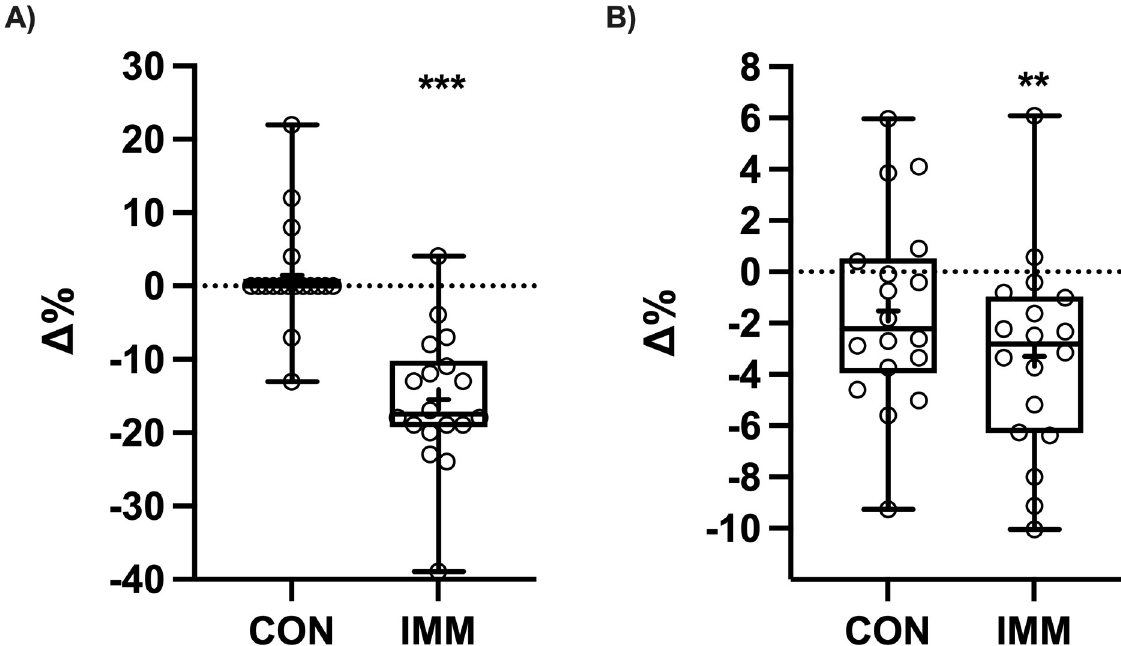
Fig 2. Phenotype change in control (CON) and immobilized (IMM) limb after 14 days of knee brace immobilization showing percent change in (A) three repetition maximum (3RM) unilateral leg press and (B) leg lean mass assessed by DEXA (n = 18). Data were analysed using two- way repeated measures ANOVA. �� P < 0.01, ��� P < 0.001 for Sˇı´da´k’s multiple comparison test (Pre- to Post-immobilization). + represents mean. Box contains the median (line) and shows 25th to 75th percentile, and whiskers represent minimum and maximum